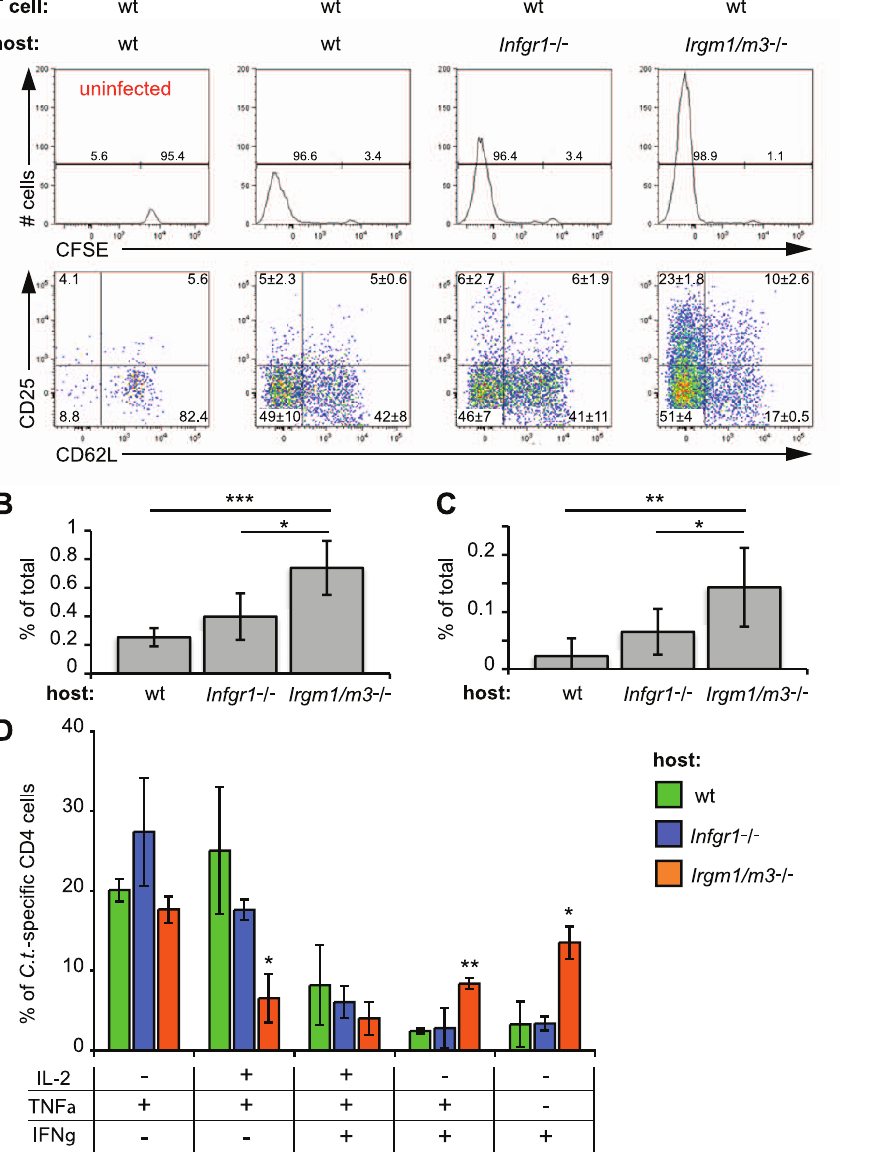
Figure 6. The absence of Irgm1/3 -dependent immunity results in an exacerbated CD4 + T cell response. CFSE-labeled, wildtype NR1cells were adoptively transferred into recipient mice of the indicated genotypes. The mice were subsequently transcervically infected with 2 * 10 6 IFUs of C. trachomatis . On day 6 post-infection, flow cytometry was used to analyze cells from the uterus and draining lymph node. Representative data of four independent experiments are shown. (A) A total of 10 6 lymphocytes were collected in each sample and the absolute number of CD4 + CD90.1 + NR1 cells was analyzed for CFSE dye dilution (upper panel) and expression of the surface proteins CD25 and CD62L (lower panel). All cells derived from the draining lymph nodes were used for the analysis. The number of C. trachomatis -specific NR1 cells is shown as the percentage of total number of cells in the iliac lymph node (B) and the uterus (C). (D) NR1 cells harvested from the iliac lymph node were also restimulated for 5 h with PMA-ionomycin and assessed for intracellular cytokine staining. Statistical significance relative to wildtype recipient mice is shown. *, p , 0.05; **, p , 0.01; and ***, p , 0.005.